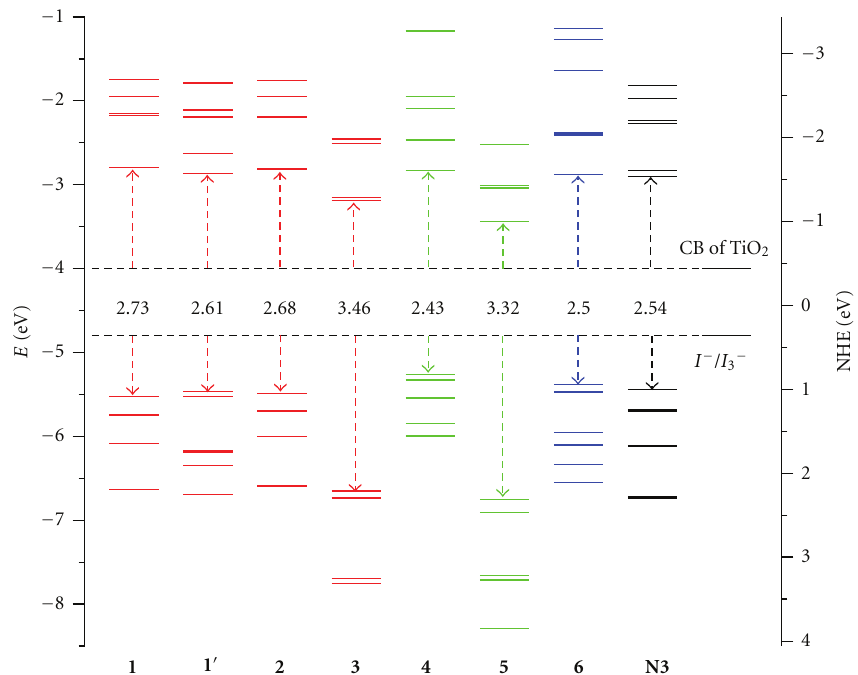
Figure 3: Energy levels and HOMO-LUMO gaps of Fe(II)-based complexes calculated at the B3LYP/6-31G ∗ level in MeCN solution.